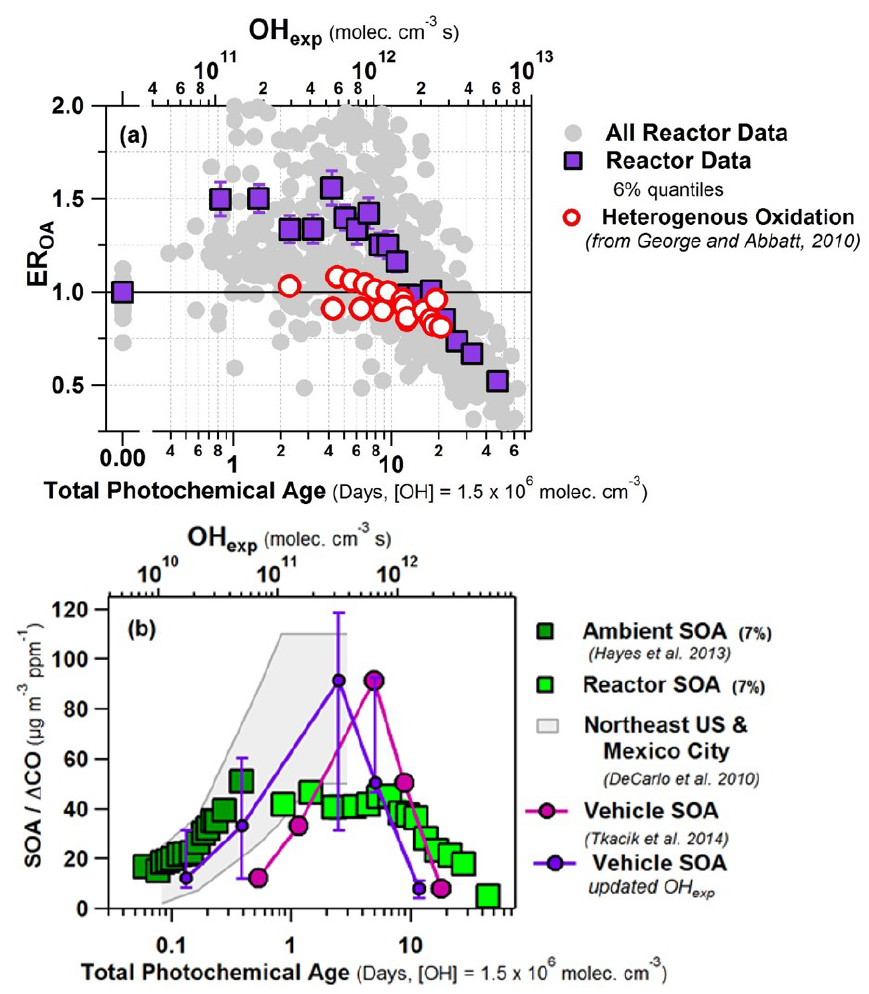
Figure 12. (a) Relative organic aerosol enhancement (ER OA ) from all reactor data in this study (including 6% quantiles), with vertical error bars indicating standard errors, and from a heterogeneous oxidation study (George and Abbatt, 2010) plotted vs. total photochemical age in days (at OH = 1 . 5 × 10 6 molec.cm − 3 ) . (b) SOA /(cid:49) CO vs. photochemical age for our study and for aging of vehicle exhaust with a similar reactor at a tunnel near Pittsburgh, PA (Tkacik et al., 2014). Results from field studies in the northeastern USA and Mexico City are shown in the background (DeCarlo et al.,